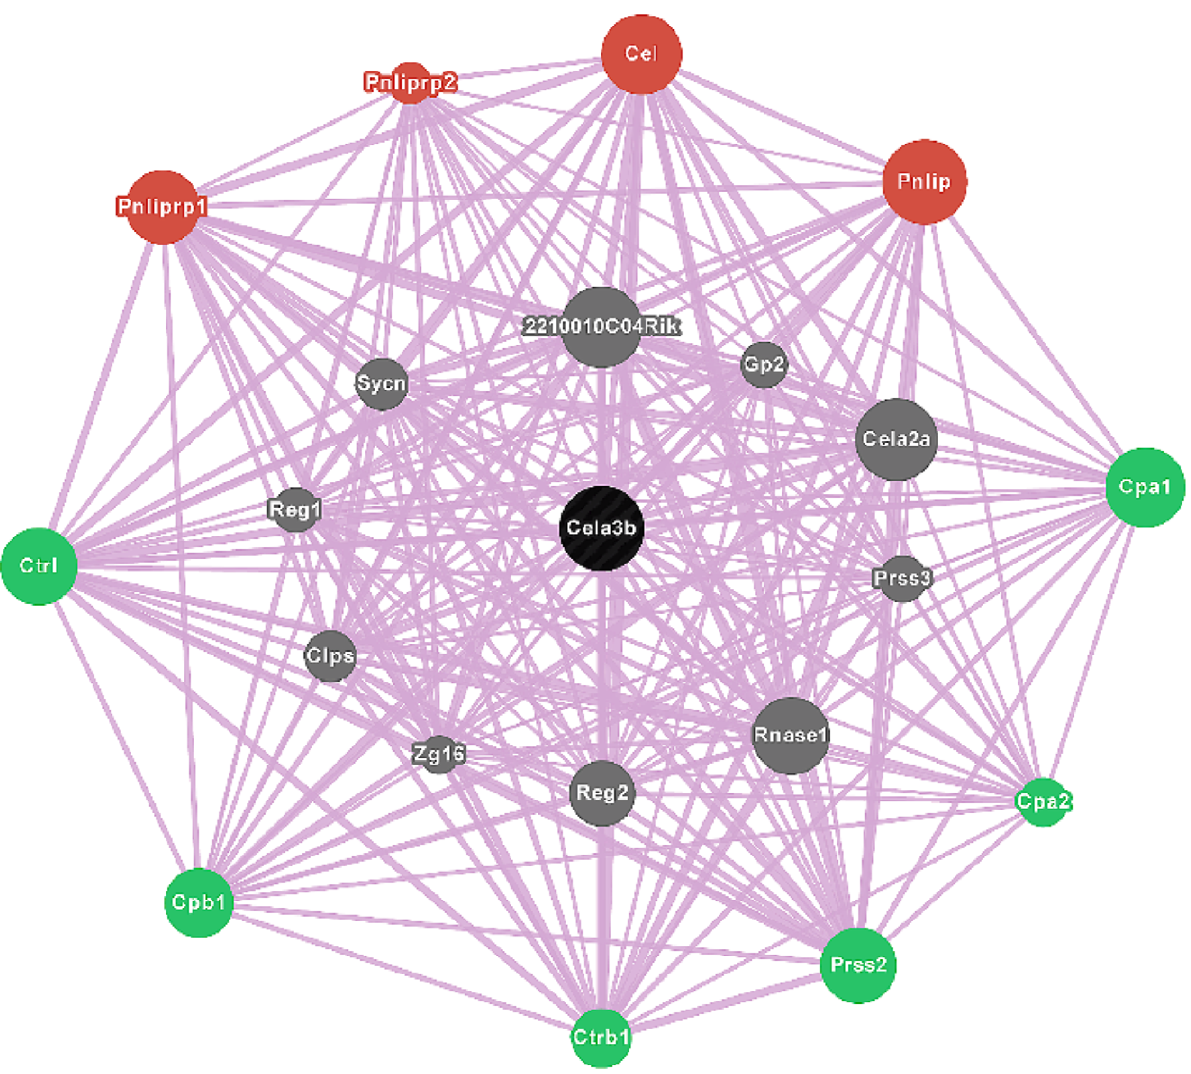
Figure 3. Epigenetic regulation of genes. GeneMANIA fast gene function predictions indicate the interrelationships between highly expressed genes in diabetic mice. The queried gene (black node), Cela3b is co-localized with numerous genes that share similar characteristics, including Cela2a , Prss3 , Rnase1, and Sync (grey nodes). Closely related peptidases, Ctrl, Cpb1 , Ctrb1 , Prss2, Cpa2 , and Cpa1 (green nodes) and lipases, Pnliprp1, Pnliprp2, Cel , and Pnlip (red nodes) are also